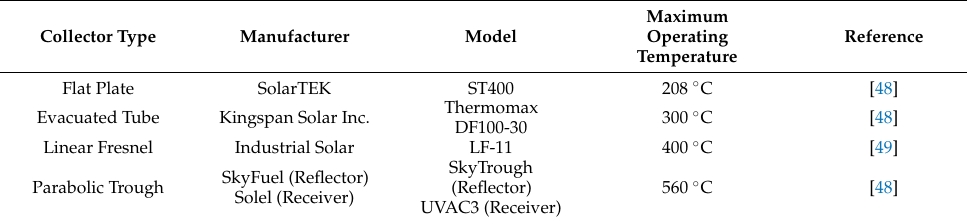
Table 4. Characteristics of the selected